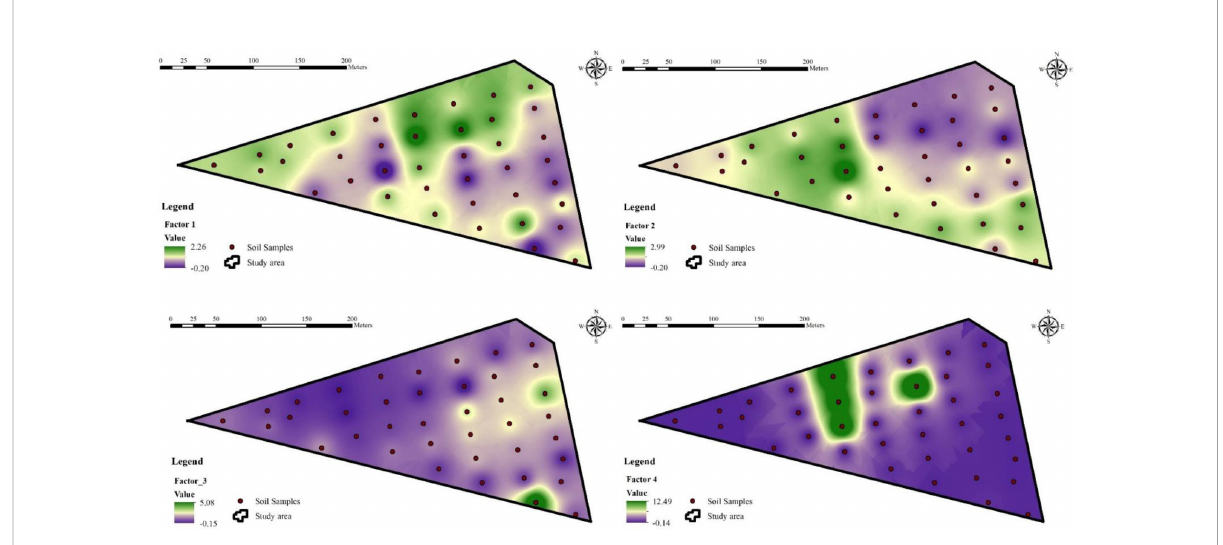
FIGURE 8 Spatial variations for the normalization from each of the four factors within the recreational